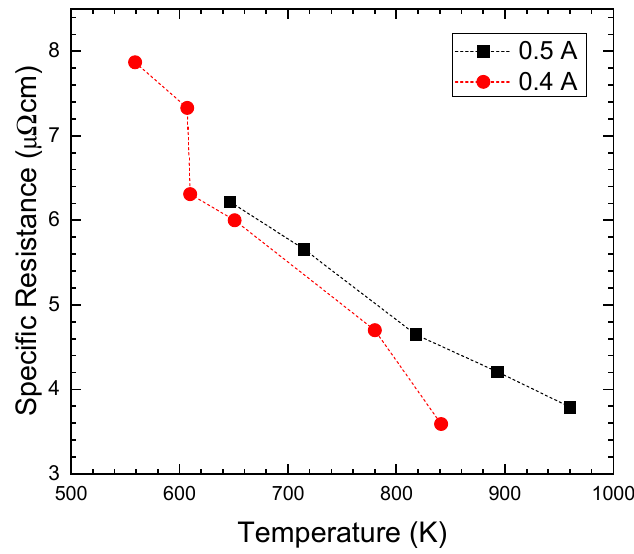
Figure 9. Relation between specific resistance of the silver nanoparticle ink and temperature with 0.5 A and 0.4 A, final-step currents.